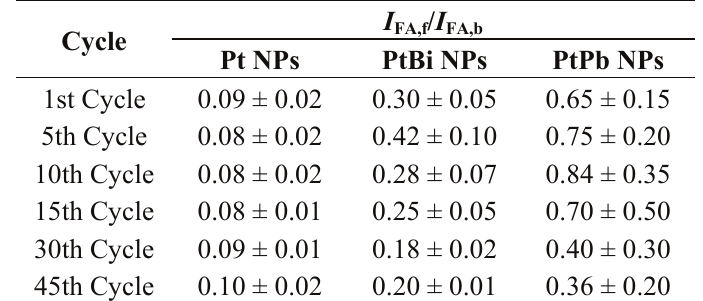
Table 2. The ratio of the current resulting from the oxidation of HCOOH to CO the forward sweep and from the oxidation of HCOOH to CO of the cyclic voltammogram of the three different electrodes coated with the mono- and bi-metallic